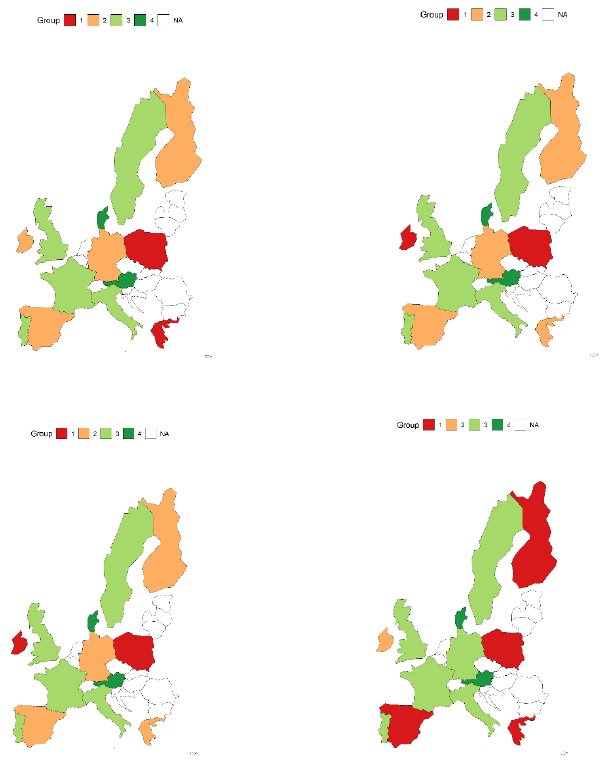
Figure 8. SISED for individual EU countries in 2015–2018.